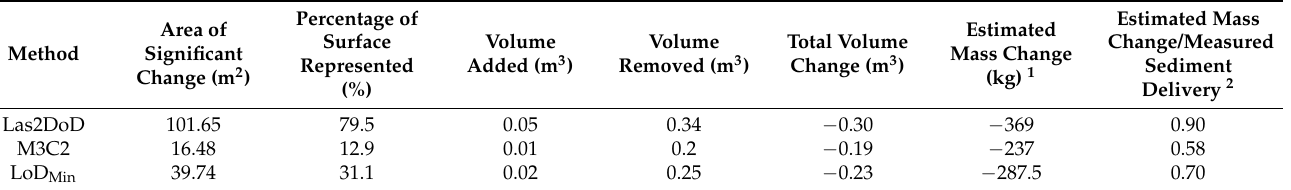
Table 1. Results from applying the three change detection methods in comparison with the plot measurements for Plot A.